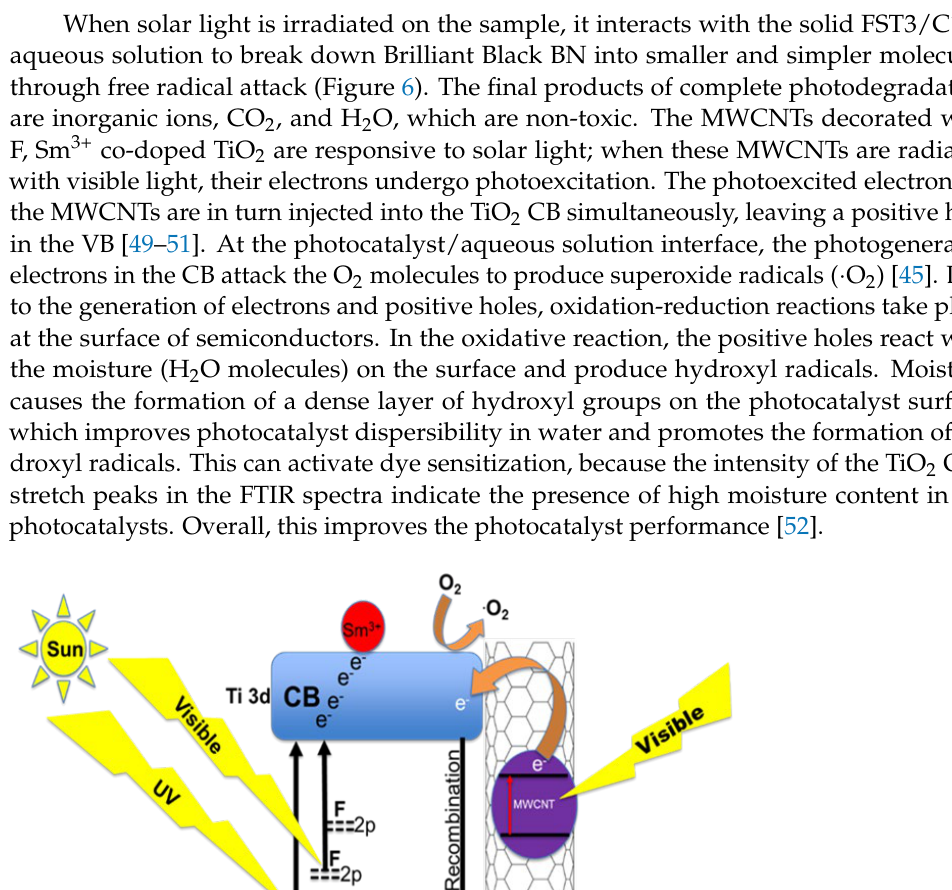
Figure 6. Proposed synergistic effects of F and Sm 3+ doping on TiO 2 -MWCNT hybrid structures.